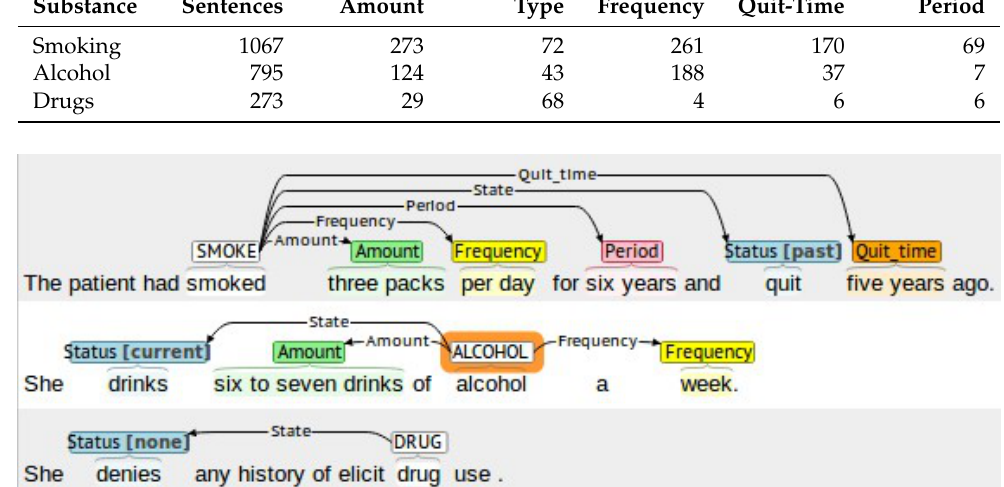
Figure 1. Example of using the BRAT annotation tool to annotate three sentences for smoking, alcohol, and drug use, respectively. Screenshot of the BRAT tool’s interface after annotating the three sentences. Using the tool, the parts of the sentence that refer to substance-use type, status, frequency, amount, period, and quit-time have been